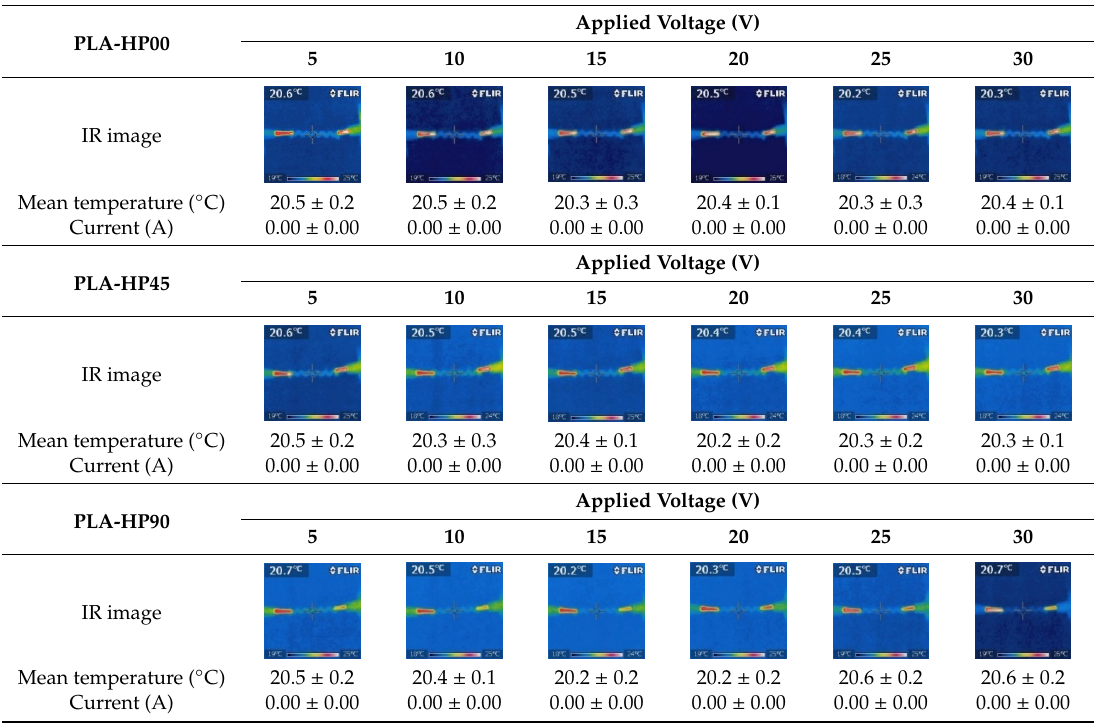
Table 6. IR images of PLA CFDM 3D-printed horseshoe pattern with different 3D printing directions.